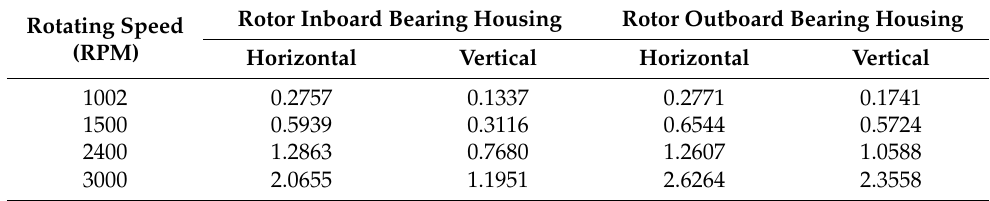
Table 2. Overall velocity-RMS (mm/s) without installing a bearing loader at no-fault condition. Rotating Speed